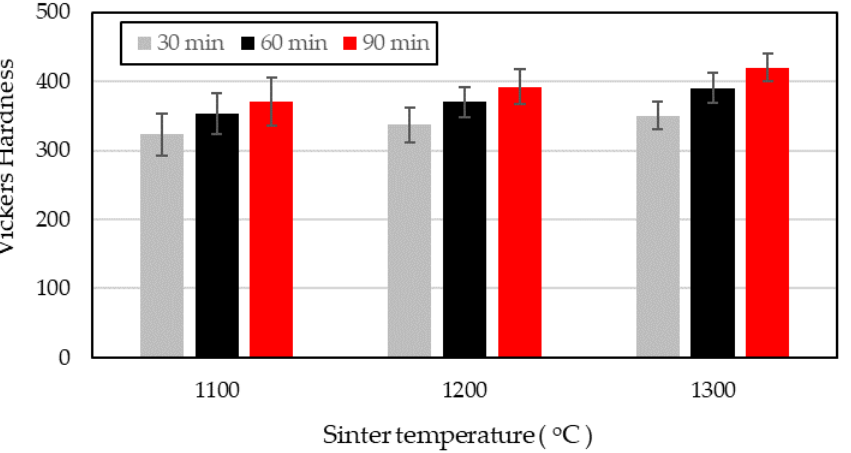
Figure 10. Surface hardness of the sintered titanium strips.